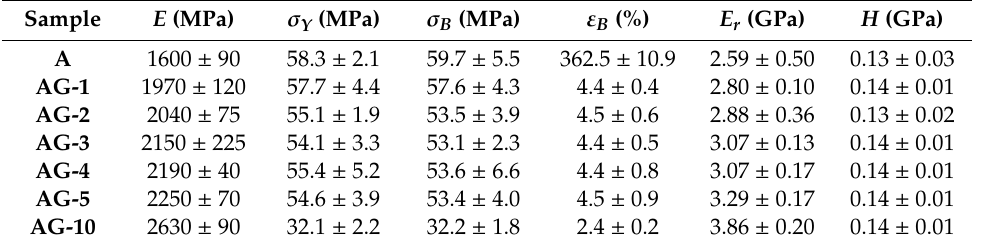
Table 4. Mechanical properties of virgin PETG filled with expanded